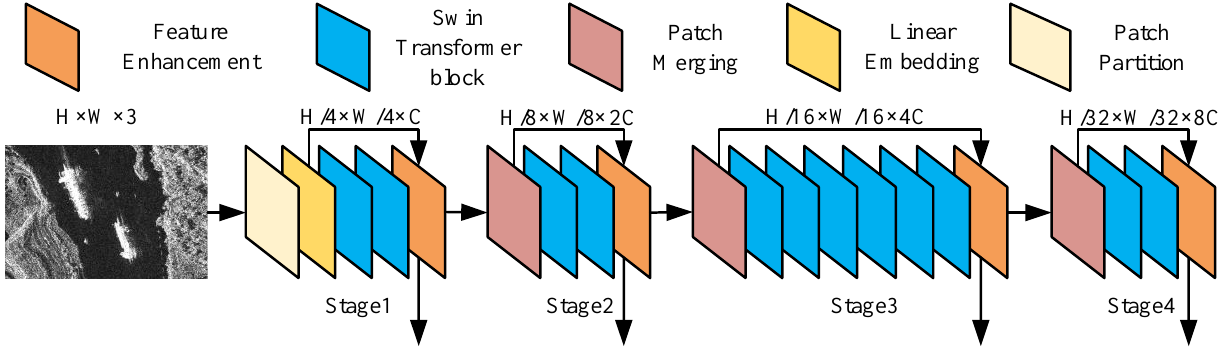
Figure 2. FESwin backbone network model. Swin transformer block [21] and feature enhancement for feature extraction, and the remaining three modules that are responsible for scaling the model.